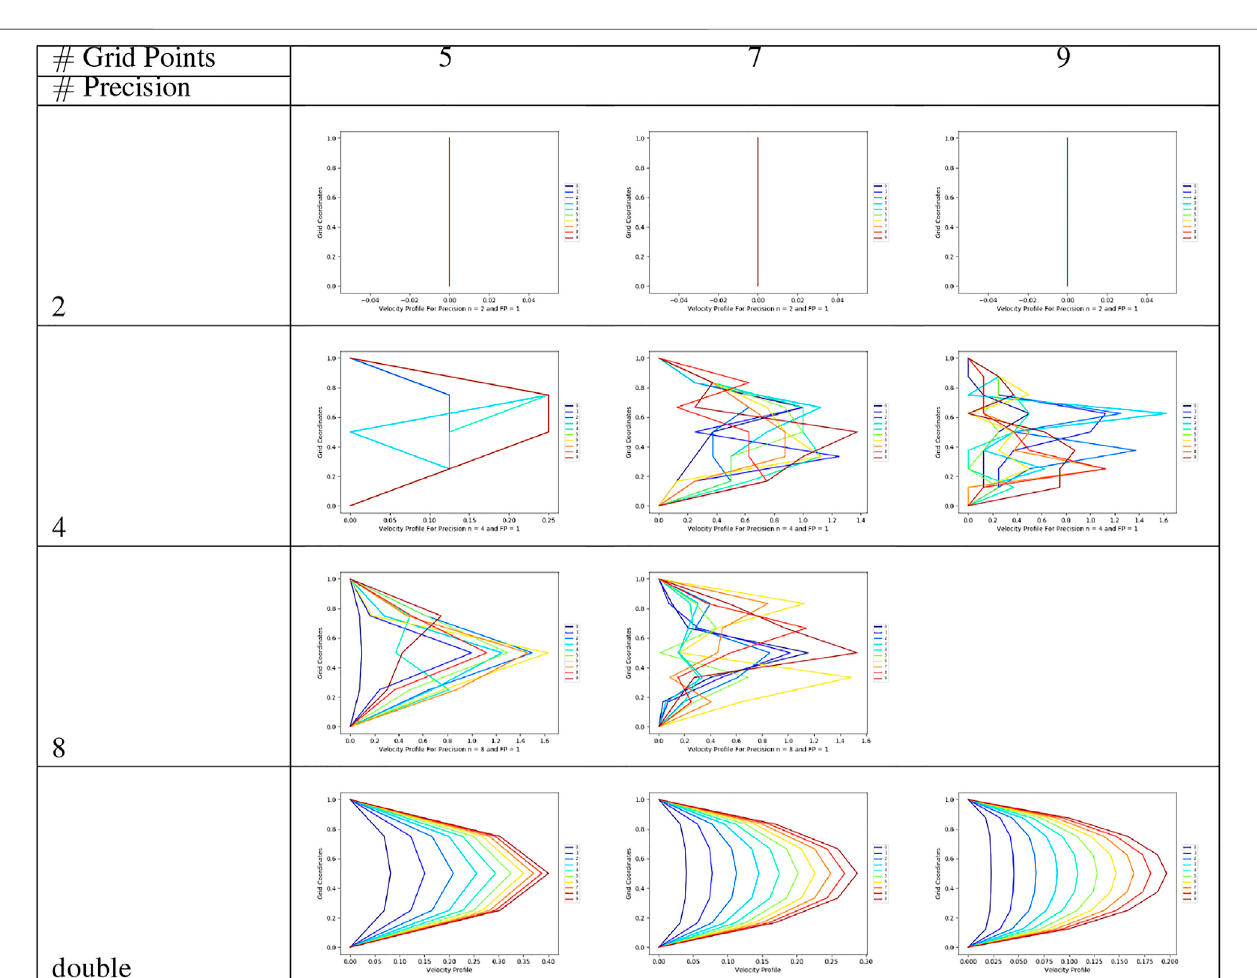
FIGURE4 | Solution pro fi les correspondingto the state with the lowest energy returned bythe hardware for precision ’ s2, 4, 8 and doublefor mesh with sizes 5, 7 and 9.